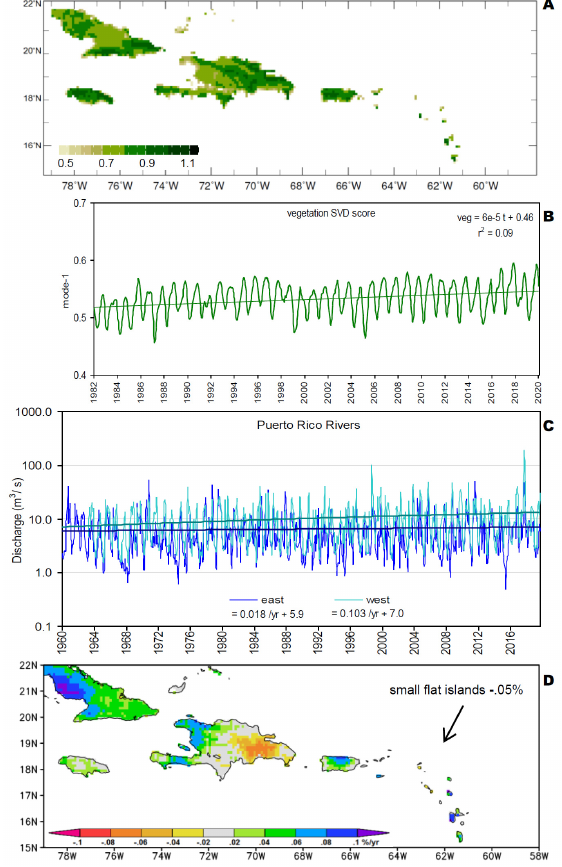
Figure 8. NASA satellite vegetation (color) fraction SVD mode-1: ( a ) loading pattern and ( b ) time score with trend. ( c ) Observed Puerto Rico river discharge in eastern (Loiza) and western (Anasco) catchments and linear trends, (gauges shown in Figure 10d). ( d ) FLDAS soil moisture trend 1981–2019 (% y − 1 ).